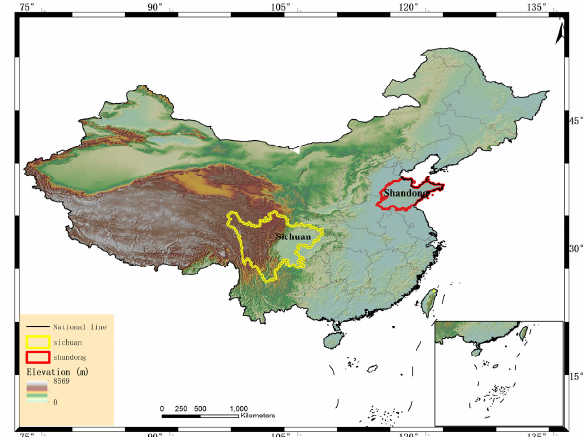
Figure 2. Chinese topographic map (data source: SRTM DEM 30s) Figure 3 and Figure 4 show the terrain of the study area. It is found that the 3 arcsec terrain data can better characterize the surface morphology than the 30 arcsec topography